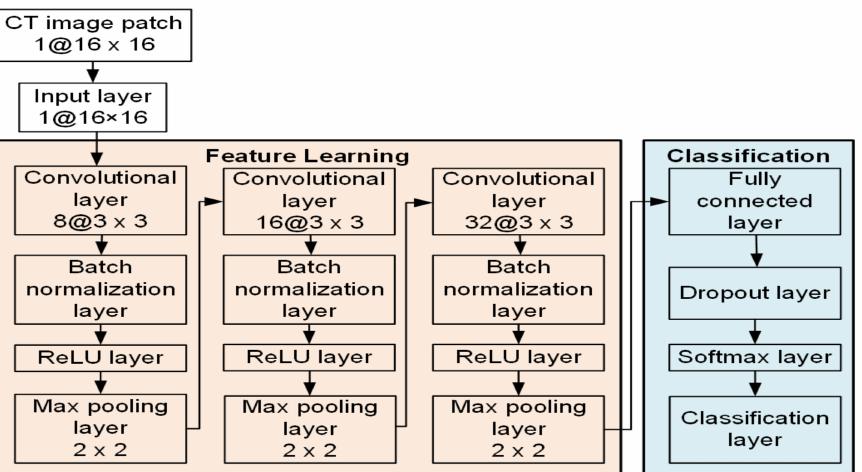
Figure 1. Schematic illustration of the proposed CNN architecture for the patch-wise classifica- tion